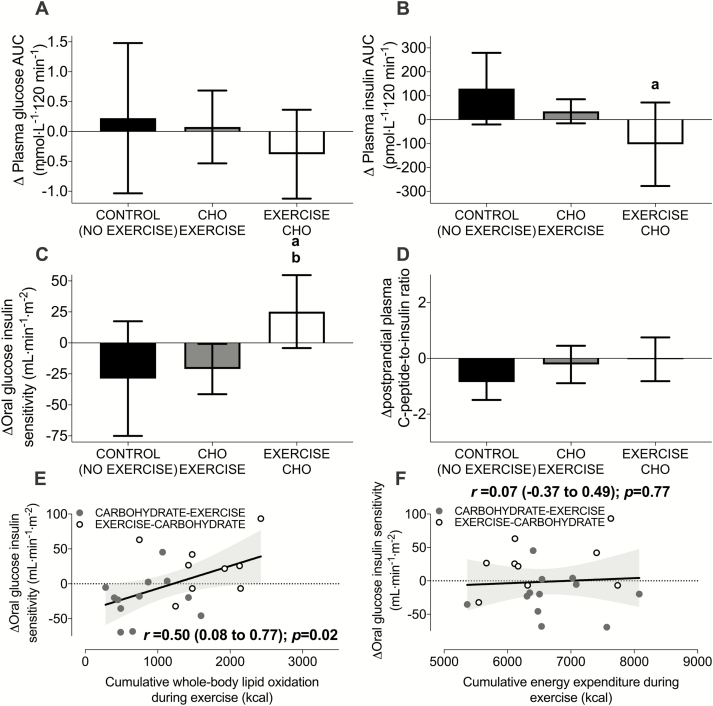
The change in the plasma glucose area under the curve (AUC; A), the change in the plasma insulin AUC (B), the change in the oral glucose insulin sensitivity index (OGIS; C), and the change in the postprandial plasma C-peptide: insulin ratio (D) in response to a 6-week training intervention with exercise performed after (CARBOHYDRATE-EXERCISE) or before carbohydrate intake (EXERCISE-CARBOHYDRATE). Panels E and F display Pearson correlations between changes in the OGIS index and cumulative lipid utilization and energy expenditure throughout the exercise training intervention, respectively. All data are presented as means ± 95% confidence interval. For control, n = 9; for carbohydrate-exercise, n = 12; and for exercise-carbohydrate, n = 9 men classified as overweight or obese. The shaded grey area represents the 95% confidence bands for the regression line. The difference between CONTROL versus EXERCISE-CARBOHYDRATE is designated by a. The difference between CARBOHYDRATE-EXERCISE versus EXERCISE-CARBOHYDRATE is designated by b (P < 0.05).